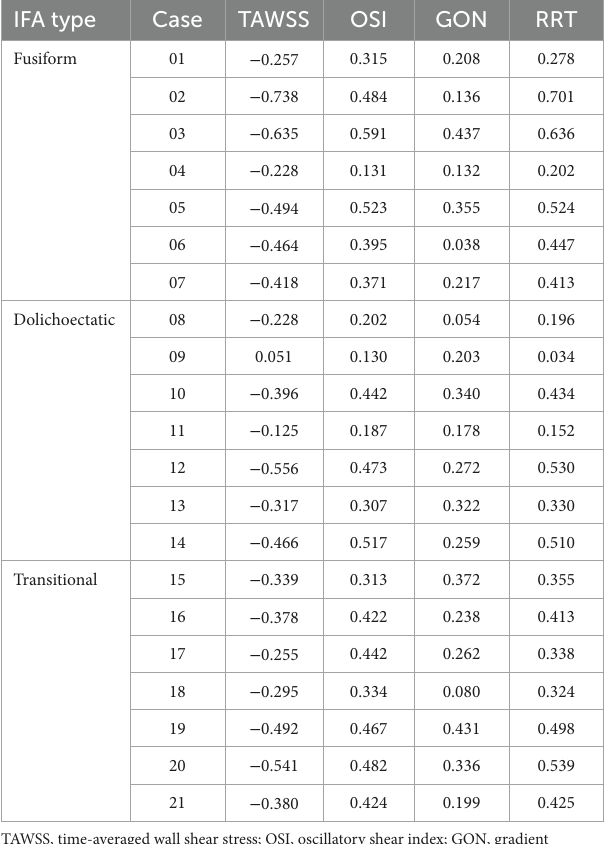
TABLE 2 Results of Spearman’s correlation analysis between the enhancement ratio (ER) and hemodynamic parameters ( p < 0.001). IFA type